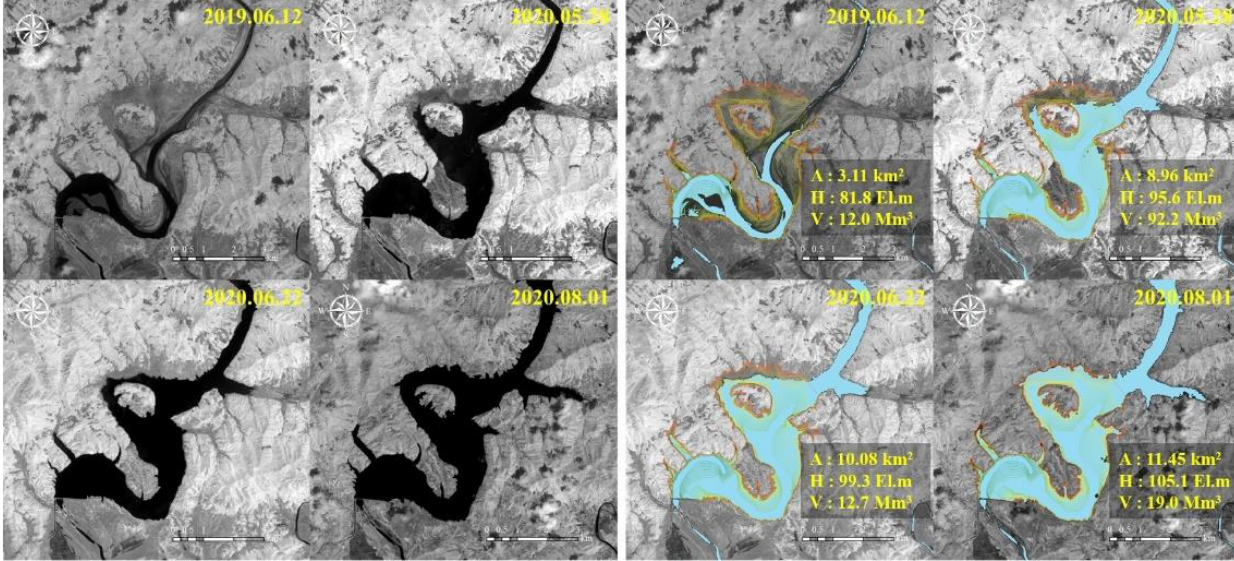
Figure 6. The near-infrared imagery of the raw Sentinel-2 images ( left ) and the NDWI water body detection images ( right ) for water surface variation monitoring.